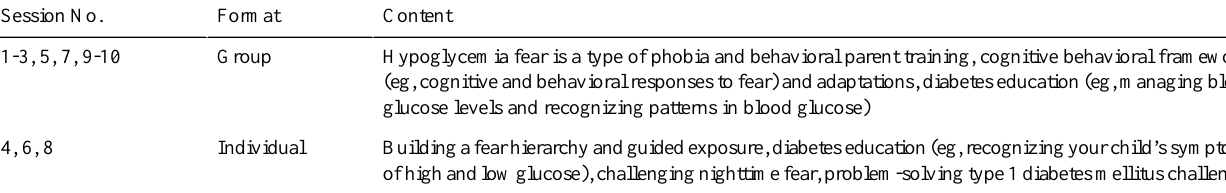
Table 1. Overview of the Reducing Emotional Distress for Childhood Hypoglycemia in Parents intervention. ContentFormatSession